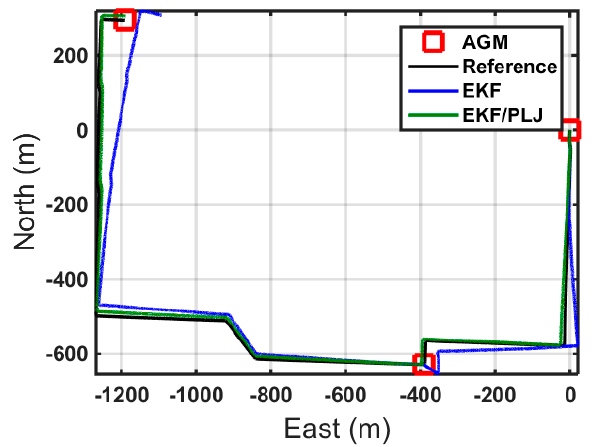
Figure 11. Trajectories—Case #1.